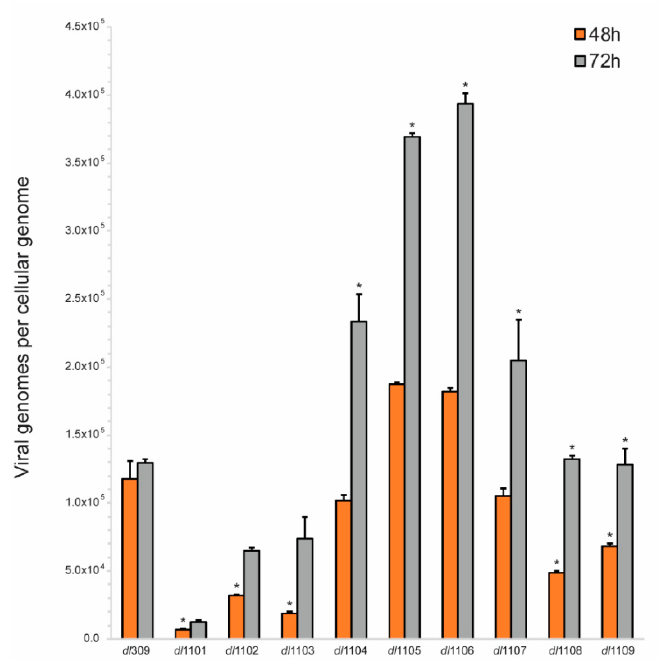
Figure 4. Viral genome replication in exon 1 E1A mutant viruses. WI-38 cells were grown until confluence at which point medium was replaced and cells were incubated for 72 h before infection with the indicated viruses at a MOI of 100. At the indicated time-points viral genomes were quantified using quantitative real-time PCR using SYBR Select Master Mix for CFX and normalized to cellular genomes using the interferon β 1 gene. Data are represented as viral genomes per cellular genome from three biological replicates. Error bars represent standard deviation of biological replicates. Asterisk denotes differences from dl 309 that are statistically significant with a p value of <0.0001.